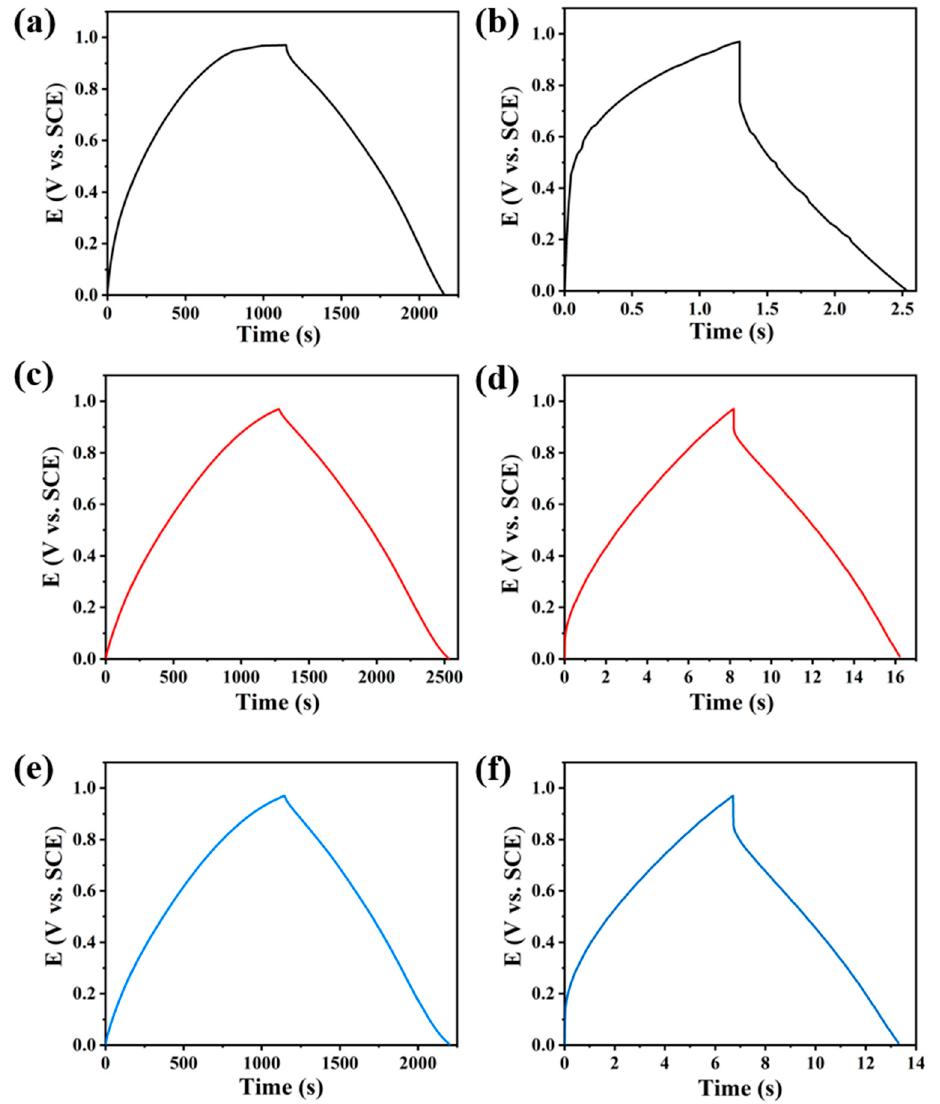
Figure 5. GCD curves of ( a,b ) MPCNF-650, ( c,d ) MPCNF-750 and ( e,f ) MPCNF-800. To further investigate the cycling performance of MPCNF-750, the MPCNF-750 sam- ple was selected as the working electrode and charged and discharged under a three-elec- trode system with a current density of 2 A g − 1 . The results in Figure 6 show that during the charge-discharge cycle, its reversible specific capacity was basically maintained at 180.0 F g − 1 after the first 100 cycles of activation, showing relative cycle stability. After 1000 cycles, its reversible specific capacity was still obtained at 179.1 F g − 1 , with a capacity re- tention rate close to 100%. It can be seen that MPCNF-750 shows certain advantages in specific capacity and cycle stability, compared with the reported works [33–36] (Table 2).